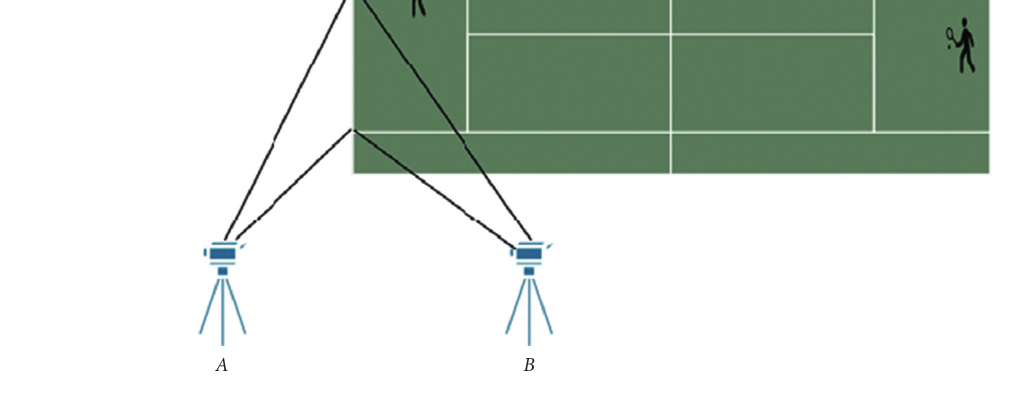
Figure 4: Experimental recording scene.